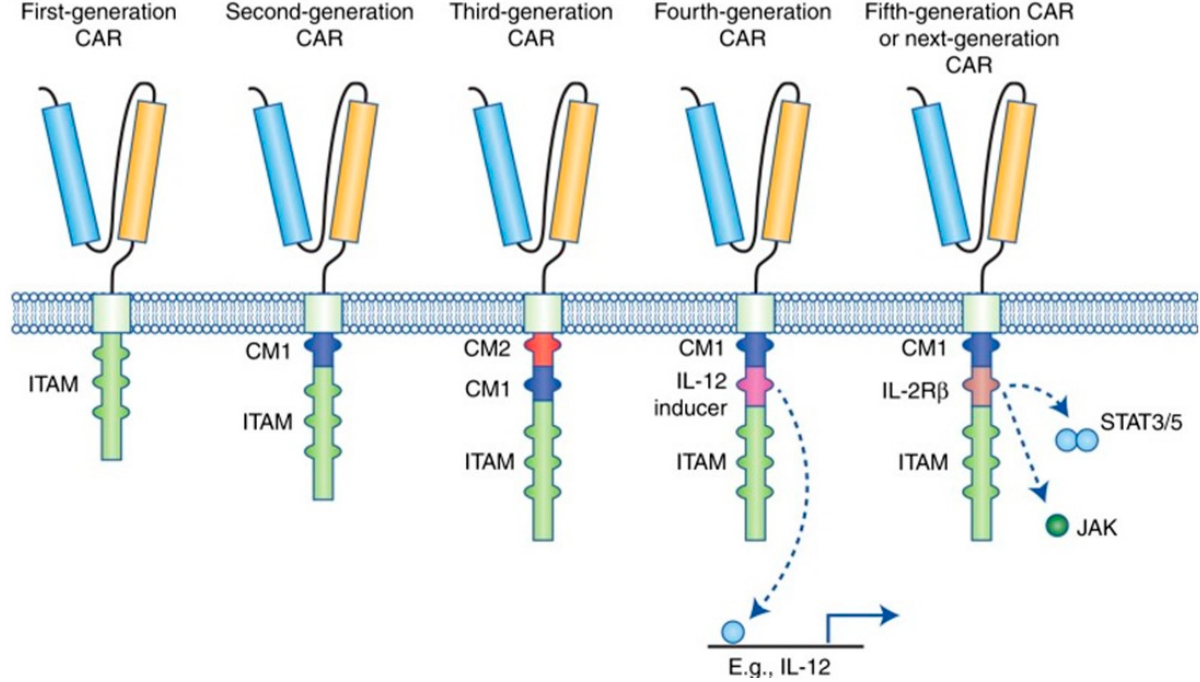
Figure 1. Molecular configuration of chimeric antigen receptor (CAR) generations. The first-generation CAR only contains immune receptor tyrosine-based activation motifs (ITAM) in the intracellular domain. Second-generation CARs incorporated one costimulatory molecule, and third-generation CARs combined a second costimulatory molecule. As the fourth-generation CAR, the TRUCK shares the molecular configuration of second-generation CAR with the addition of a constitutive cytokine inducer. The fifth-generation CAR shares the molecular construct of the second generation, with the additional intracellular domains of cytokine receptors such as the IL2R ß chain fragment [38]. CAR: chimeric antigen receptor, scFv: single-chain fragment variable, ITAM: immunoreceptor tyrosine-based activation motifs, TRUCK: T cell redirected for universal cytokine- mediated killing, IL2R ß: IL-12 receptor ß chain